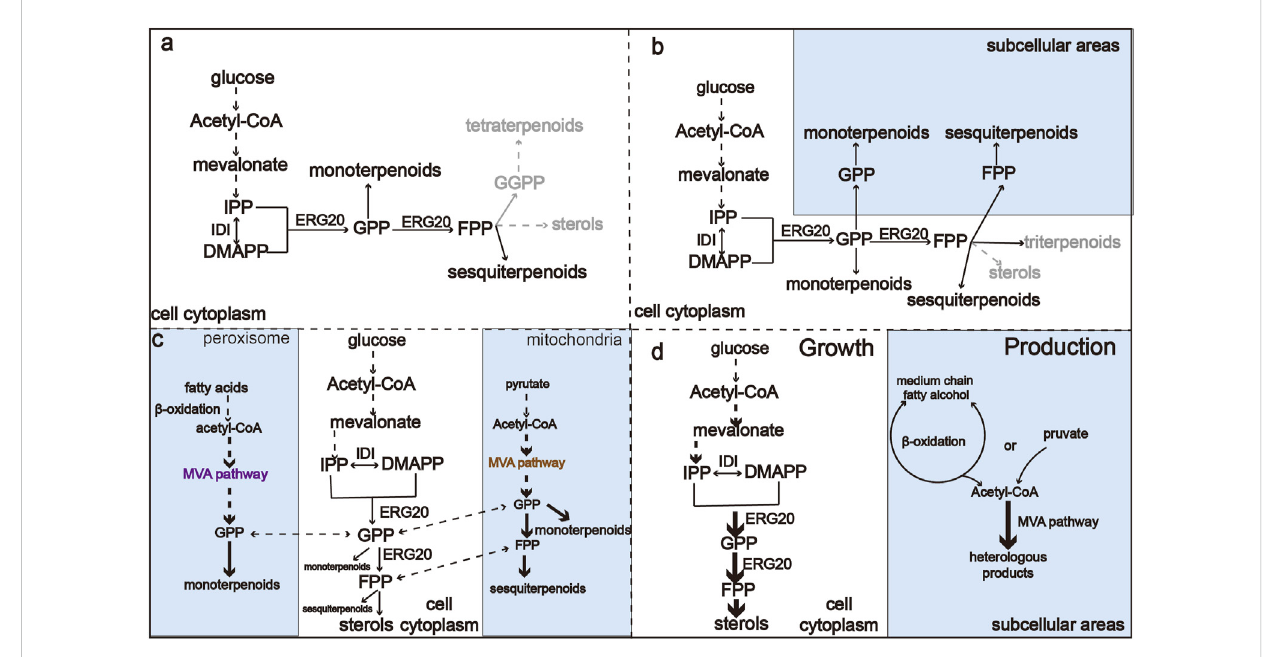
FIGURE 2 An overview of metabolic regulation of monoterpenoid and sesquiterpenoid biosynthesis pathways. (A) Monoterpenoid and sesquiterpenoid biosynthesispathway inthecytoplasm. (B) HarnessingGPPandFPPinbothcytoplasm andorganellesto improvetheproductionofmonoterpenoids and sesquiterpenoids. (C) Harnessing acetyl-CoA in organelles to improve the production of monoterpenoids and sesquiterpenoids. (D) Engineering compartmentalization for orthogonal biosynthesis of monoterpenoids and sesquiterpenoids to reduce competing